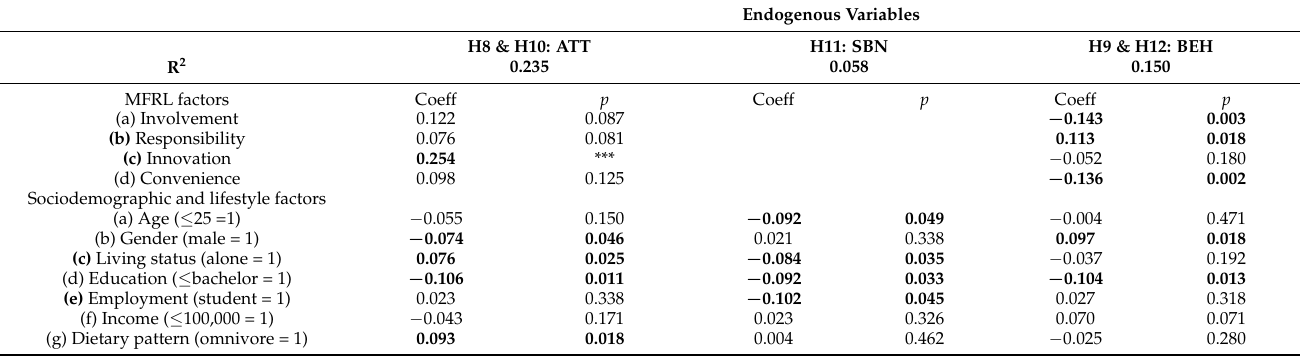
Table 9. Path analysis between background factors and constructs of the proposed TRA extended